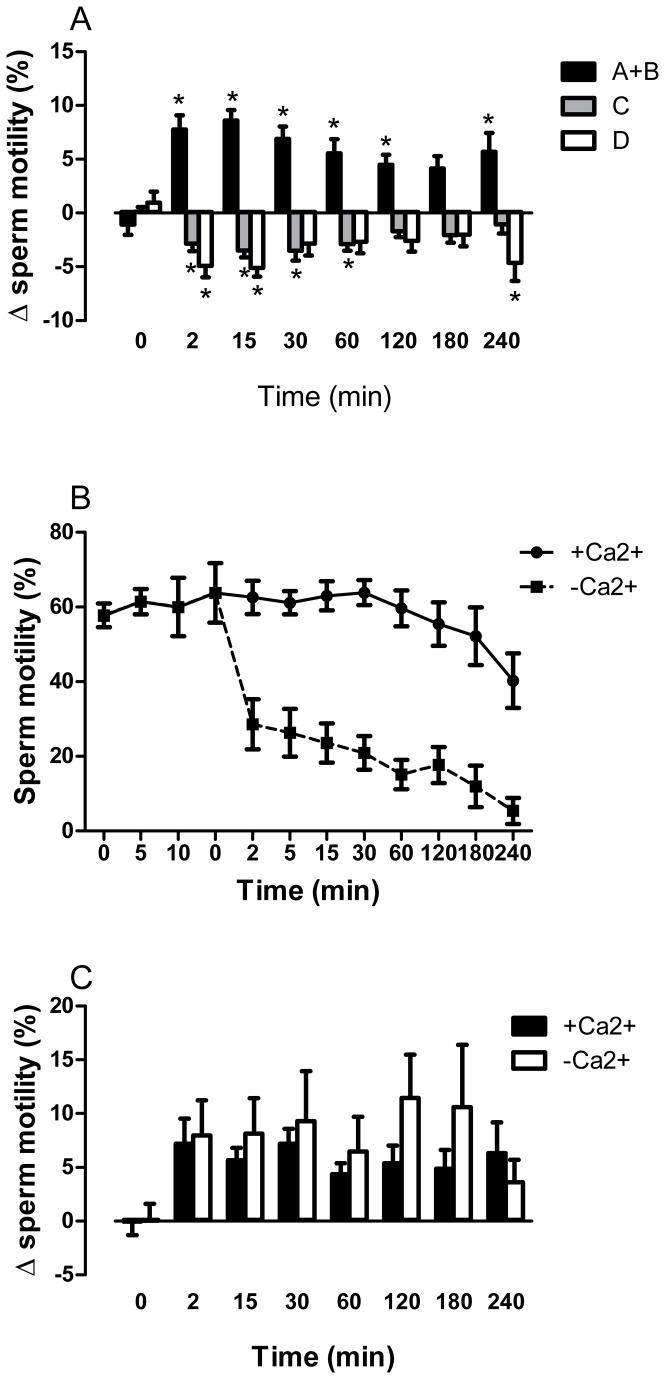
Effects of veratridine on human sperm motility in Ca2+-containing and Ca2+-free mHTF solution.(A) Effects of veratridine (10 μM) on progressive motility (grade A+B sperm), non-progressive motility (grade C sperm) and immotility (grade D sperm) at different times of incubation in Ca2+-containing mHTF solution. Bars are means with SEM of 36 different experiments and represent percentage changes in motility in samples treated with veratridine relative to the value observed at the same time in solvent-treated paired controls. *P<0.05, significant difference vs. control responses. (B) Time-dependent inactivation of sperm motility after incubation in a Ca2+-free mHTF solution. Afer capacitation for 2 h at 37°C in 5% CO2, the sperm suspension was divided in two aliquots, one of them incubated in Ca2+-containing solution and the other one in Ca2+-free solution. Data points are means with SEM of 7 different experiments and represent % motile sperm (grade A+B sperm). (C) Effects of veratridine (10 μM) at different times of incubation in Ca2+-containing and Ca2+-free mHTF solution. Bars are means with SEM of 7 different experiments and represent percentage changes in progressive motility (grade A+B sperm) relative to the value observed at the same time in solvent-treated paired controls.